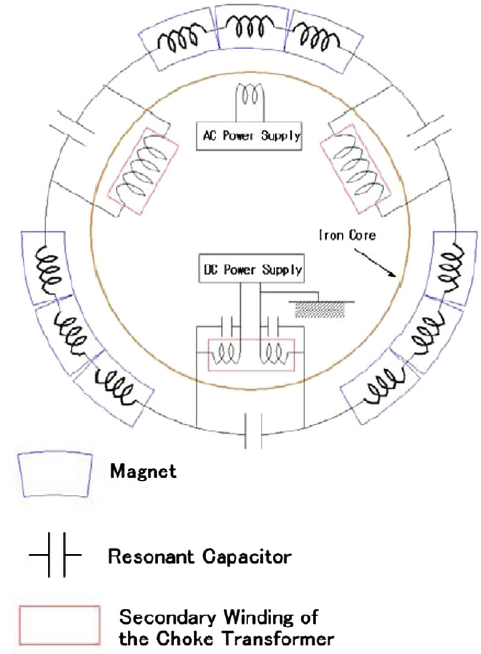
FIG. 14. Resonant network for excitation of KEK-DA main magnets.